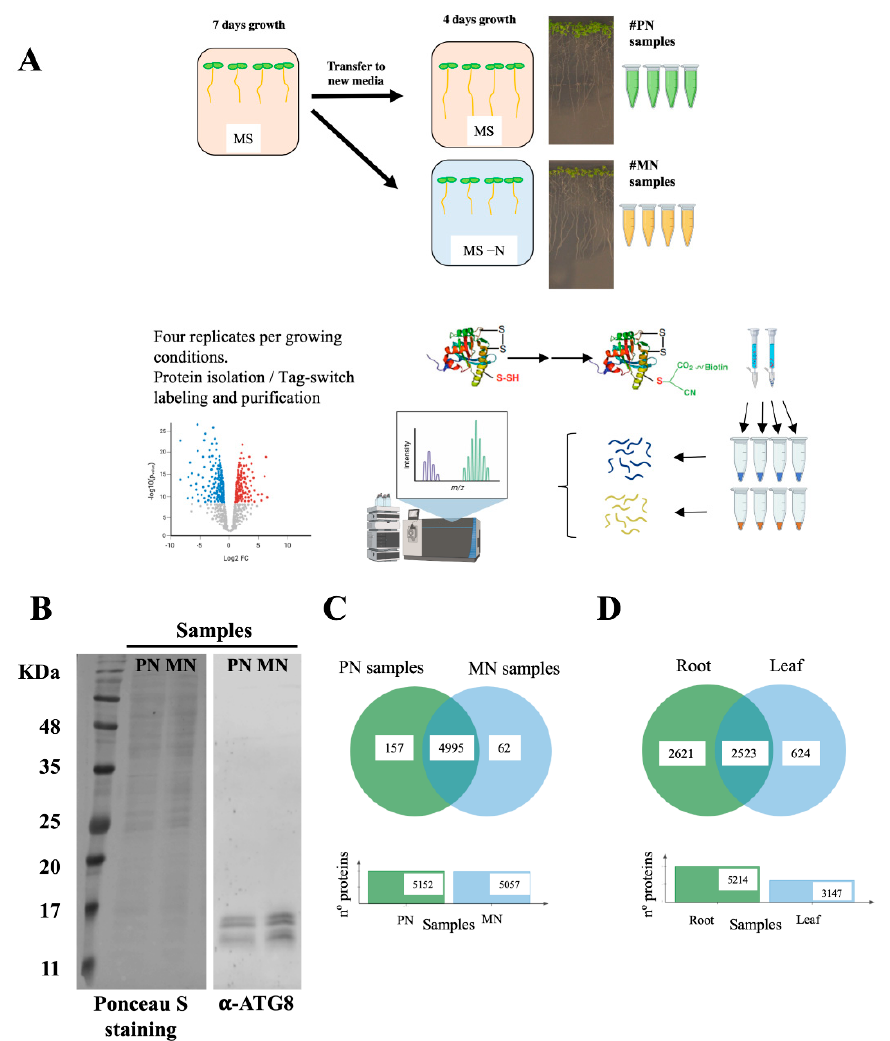
Figure 1. Proteomic analysis of protein persulfidation in response to N starvation in root tissue. ( A ) Workflow of the root sample preparation followed by tag-switch protein labeling with CN-biotin, protein purification, tryptic digestion and quantitative DIA analysis of eluted proteins. ( B ) Immunoblot analysis of ATG8 protein accumulation in roots. Total protein extracts from the PN and MN samples were subjected to immunoblot analysis with anti-ATG8. As a protein control, Ponceau S staining of the blot is shown. ( C ) Venn diagram showing the intersection of the persulfidated protein sets identified in the root samples grown in N-sufficient media (PN samples) and N-depleted media (MN samples). ( D ) Venn diagram showing the intersection of the persulfidated protein sets identified in root tissue and reported leaf tissue [15].